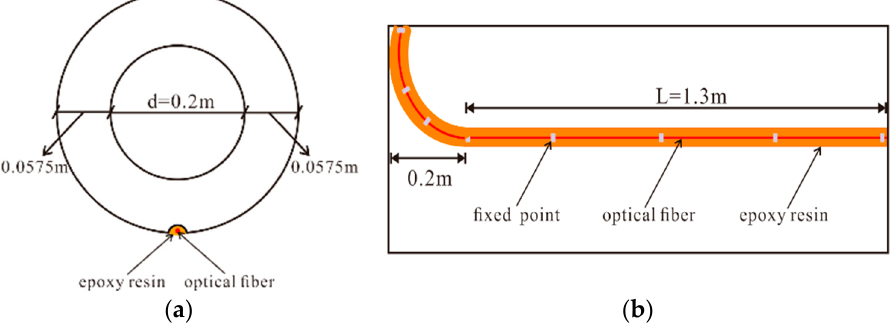
Figure 5. Optical fiber bonded to the pile. ( a ) Fiber on the pile cross section; ( b ) Fiber along the pile